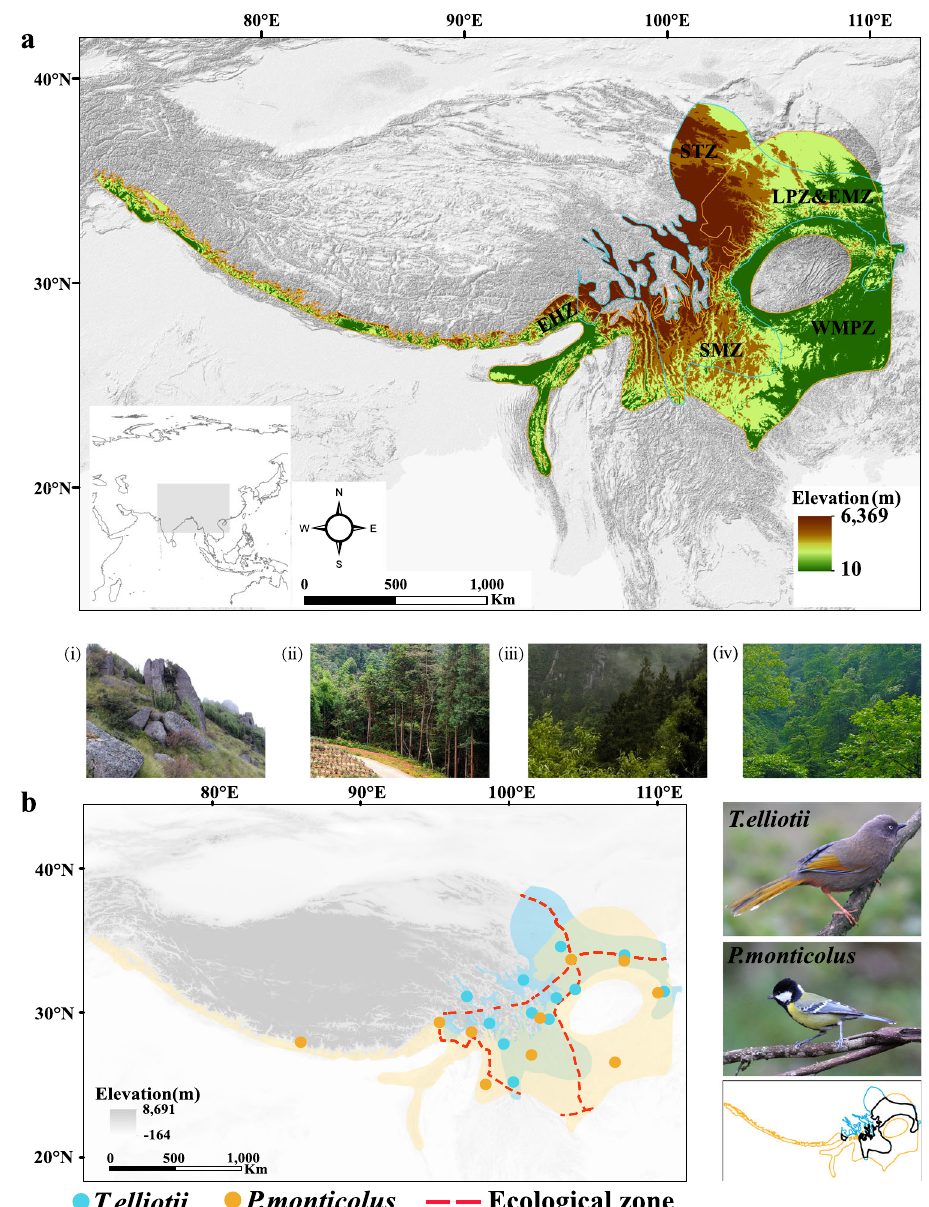
Fig. 2 | Sino-Himalayan Mountains and distribution ranges of the two moun- tainous species studied. a The distribution ranges of P. monticolus and T. elliotii cover the Sino-Himalayan Mountains and mid-elevational mountains in Central China.The southern Tibetanzone (STZ) is in the southeastern partof the Qinghai- Tibetan Plateau, which has an average elevation of 4500m a.s.l. This zone is dominated by shrubland (i).Thesouthwestmountainouszone (SMZ)hasa vertical climatic zonation along an elevation gradient, ranging from the temperate con- iferous forest (ii), mixed forests (iii) and subtropical broadleaf forest (iv). The eastern Himalayan zone (EHZ) is on the southern margin of the Qinghai-Tibetan Plateauand encompasses a broad range ofecological habitats varying from grassy meadows to a dense humid evergreen forest (i-iii). The western mountainous